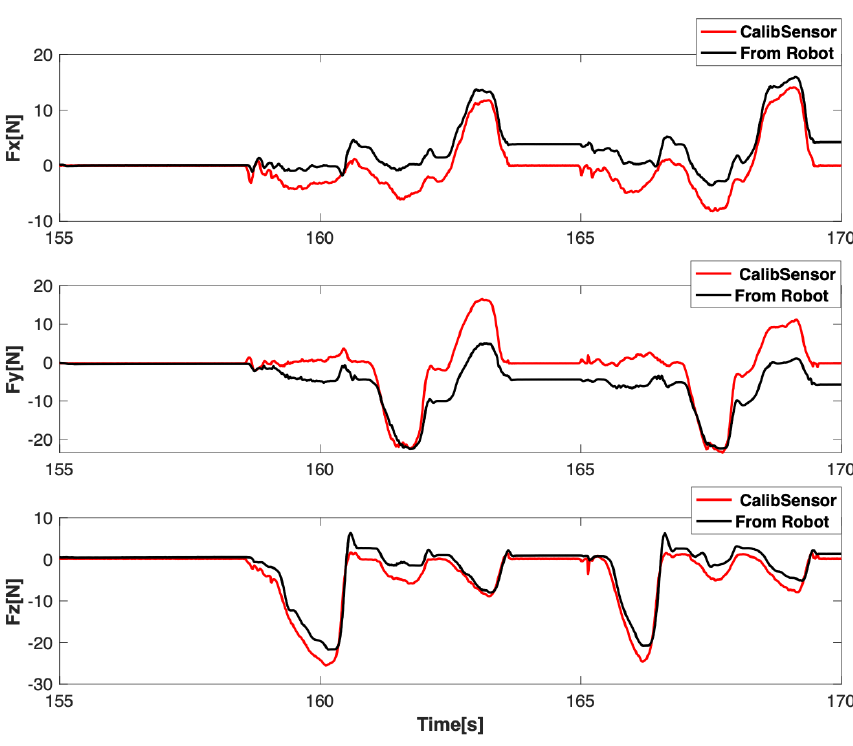
Figure 14. The calibrated force using singular value decomposition (SVD) after tool dynamic